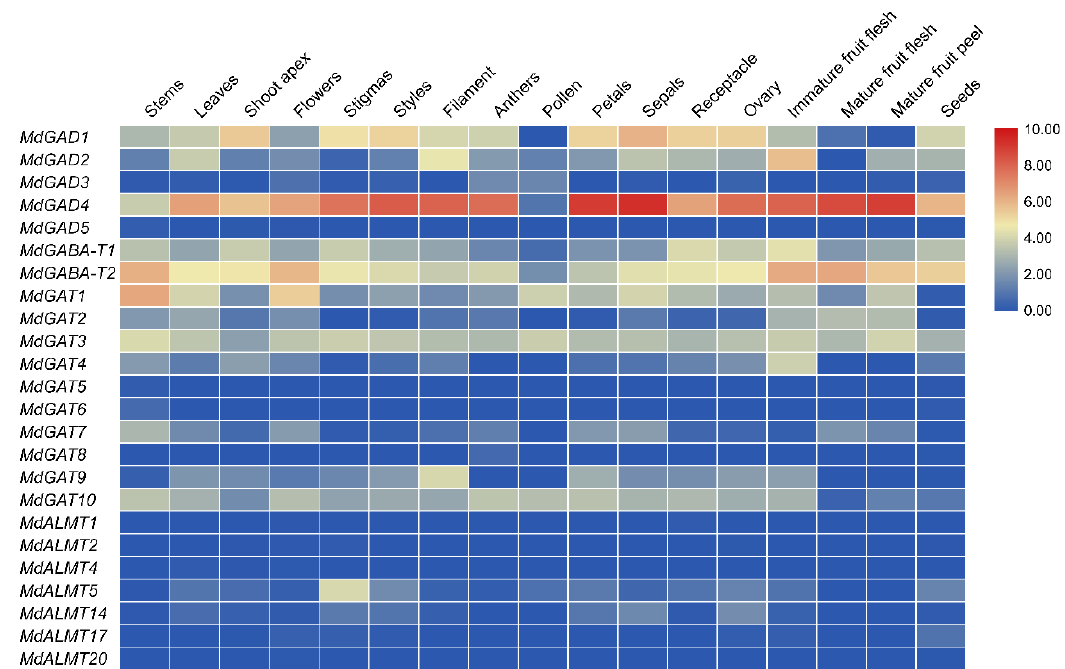
Fig. 5. Heat map of GABA signal pathway genes in the stem, leaves, flower organ, fruit and seed tissues. Relative expression values with color blue (low) to red (high) are displayed at the bottom.